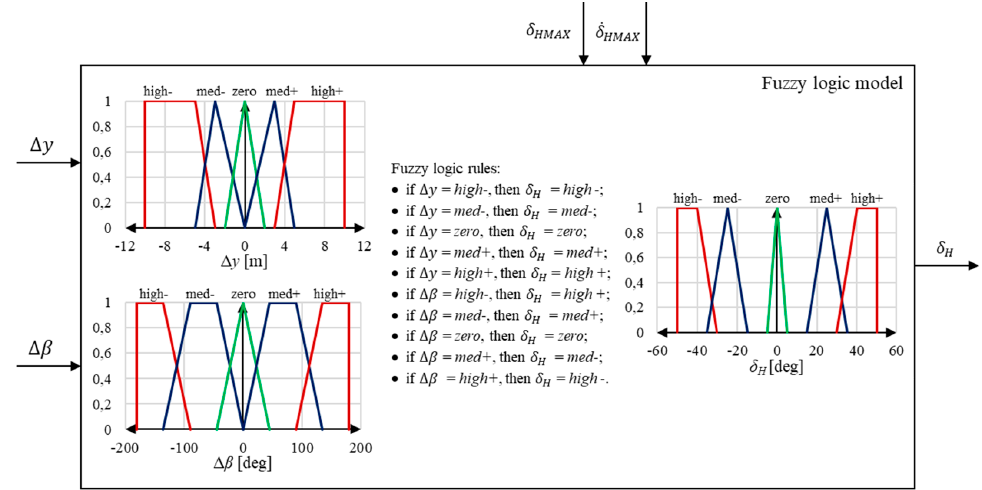
Figure 5. Structure of the fuzzy logic model used.